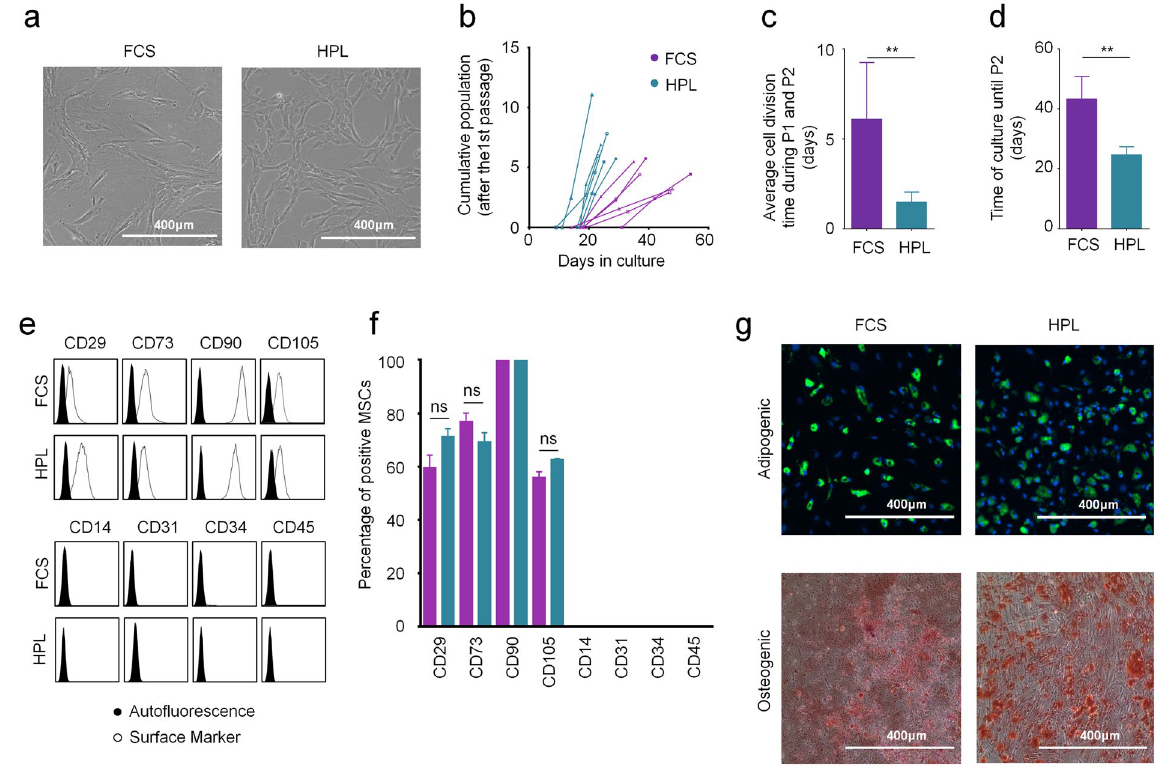
Figure 1. Growth and differentiation of MSCs in HPL and FCS. ( a ) Phase contrast images of MSCs (passage 2) that were in parallel cultivated in HPL and FCS. ( b ) Population doublings (PDs) within the first two passages were compared in HPL-MSCs and FCS-MSCs (n = 6). PDs in passage zero are not considered due to lack of initial cell numbers. ( c ) Average doubling time during passage 1 and 2 was shorter in HPL than FCS ( ** p < 0.01). ( d ) The time from initial isolation to passage two was shorter in HPL than in FCS ( ** p < 0.01). ( e ) Histograms depict the immunophenotype of MSCs isolated in FCS or HPL (autofluorescence in black). ( f ) The percentages of positive MSCs for the immunophenotypic markers did not differ in FCS or HPL. ( g ) HPL- MSCs and FCS-MSCs at passage 2 were in parallel induced with the same differentiation media for three weeks towards adipogenic or osteogenic lineage, and then stained for fat droplets or calcium precipitates (BODIPY/ DAPI and alizarin red,